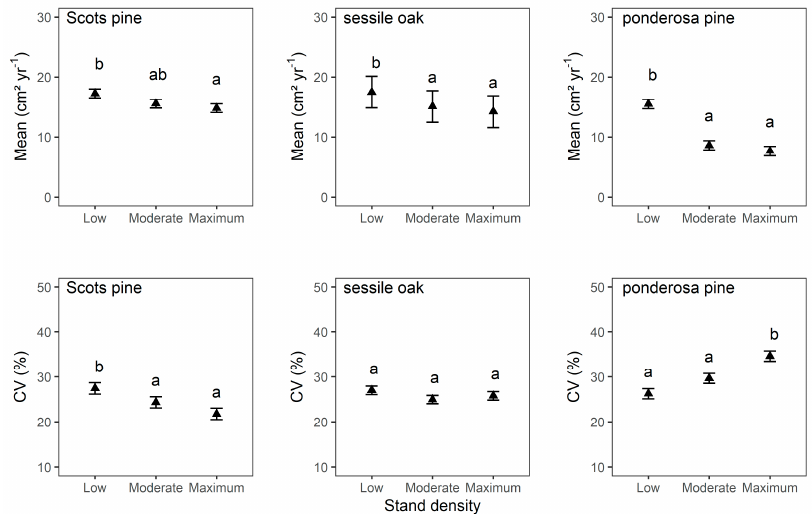
Figure 2. Estimated least-squares means of mean tree basal area increment ( Mean , cm 2 yr − 1 ) and mean coe ffi cient of variation ( CV , % ), representing mean tree growth sensitivity, according to Equation (7) (Table A3) for Scots pine, sessile oak and ponderosa pine growing under di ff erent stand density levels ( low, moderate, maximum ) based on 409 trees (Scots pine: 139; sessile oak: 135, ponderosa pine: 135). Mean was calculated on raw bai series, while CV was calculated on detrended bai index series. Significant di ff erences between the means ( p < 0.05) are indicated by lower case